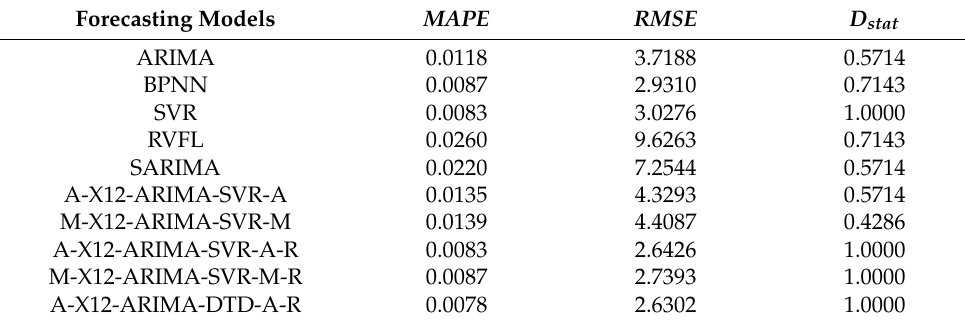
Table 12. Performance comparison of different models in Shandong.